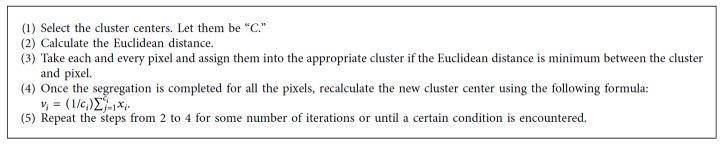

k-Means clustering.